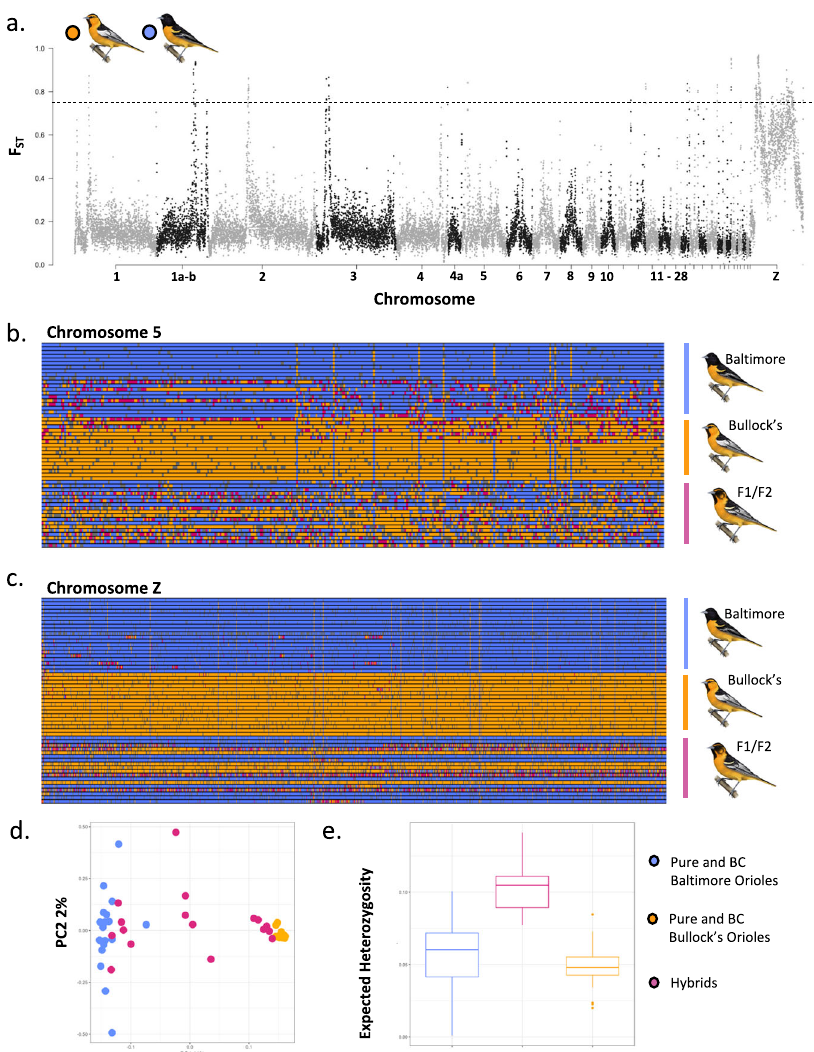
Fig. 2 The genomic architecture of divergence between Baltimore and Bullock ’ s orioles. a genome-wide F ST estimates between allopatric Baltimore and Bullock ’ s orioles in 50 kb windows. Dashed line represents the 99 th percentile of the mean ( F ST = 0.75). b Genotype plot for chromosome 5 shows an example of admixture patterns for fi xed SNPs across the chromosome. Blue represents homozygotes for the reference allele, orange is homozygotes for the alternate allele, and heterozygotes are in pink. Colors are polarized using a Baltimore Oriole. c Genotype plot for the Z chromosome shows an example of admixture patterns for fi xed SNPs. Blue represents homozygotes for the reference allele, orange is homozygotes for the alternate allele, and heterozygotes are in pink. Colors are polarized using a Baltimore Oriole. d PCA of SNPs associated with the larger elevated MDS region (as shown in the dashed black lined box). The 55 individuals sort into three clusters with the ends representing putative homozygotes for the inversion and the middle representing individuals that are putative heterozygotes for the inversion orientation. Individuals are color coded as allopatric/backcrossed for either parental species or hybrid (for this analysis, the hybrid category corresponds only to F1/F2 individuals). Genotypic classes are based on reduced representation sequencing data (see methods). e As predicted, heterozygosity for putative heterozygotes for the inversion is higher than that observed in homozygous individuals. Heterozygosity estimates were calculated for individuals assigned to each of the three clusters based on PCA results from panel c . Color coding for panel e is the same as that in panel d